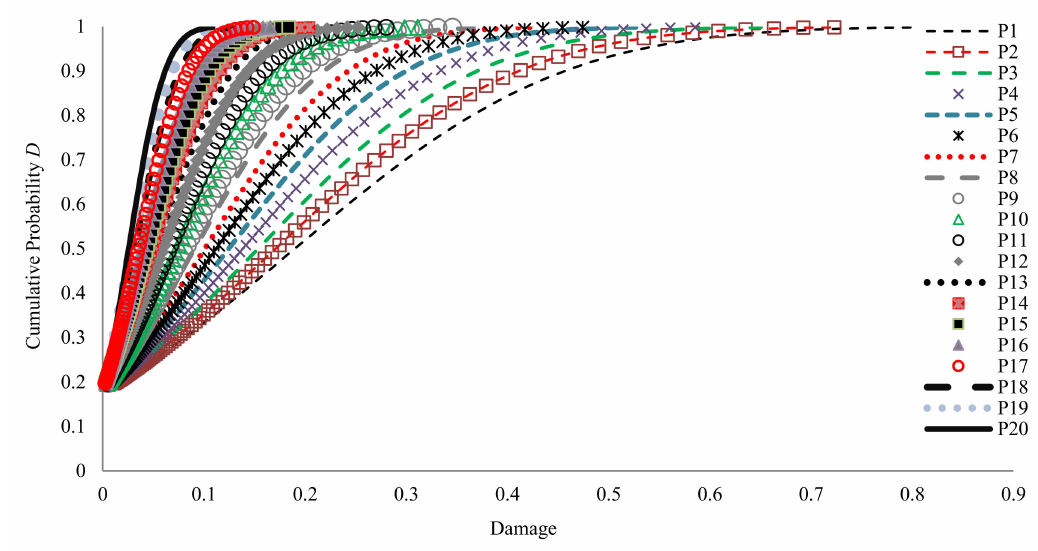
Figure 2. The suggested damage range in the coal–rock interface ( D